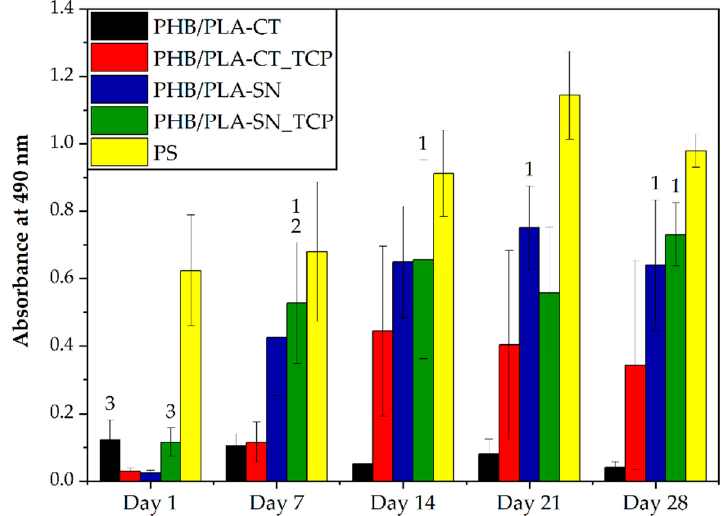
Figure 5. Metabolic activity of cells on the scaffolds. The numbers above the column indicate statistically significantly higher values compared to the column of that number, p < 0.05.